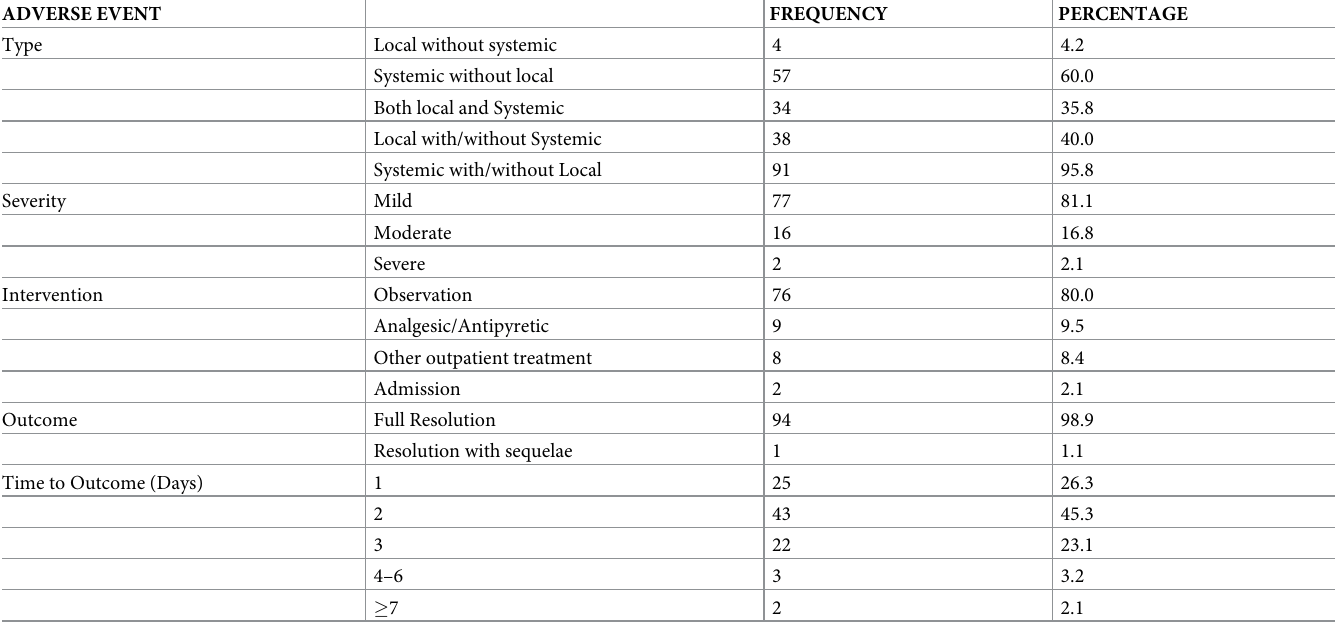
Table 2. Adverse event type, severity, intervention, and outcome.